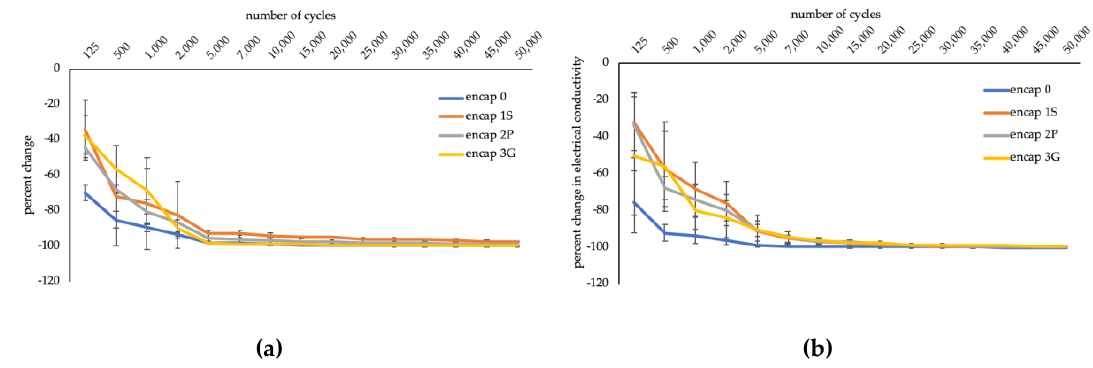
Figure 4. Performance of functionalized fabrics with abrasion. ( a ) Wool. ( b ) Cotton.